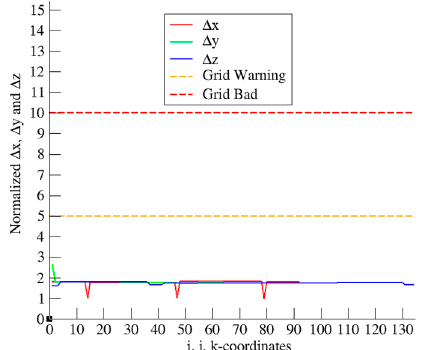
Figure 15. Grid quality check of 800,000-mesh